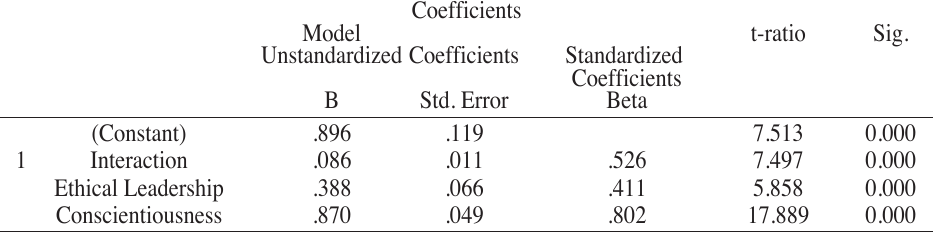
Table 7 Moderation Effect of Conscientiousness on the Relationship of Ethical Leadership and Employee Well-Being: